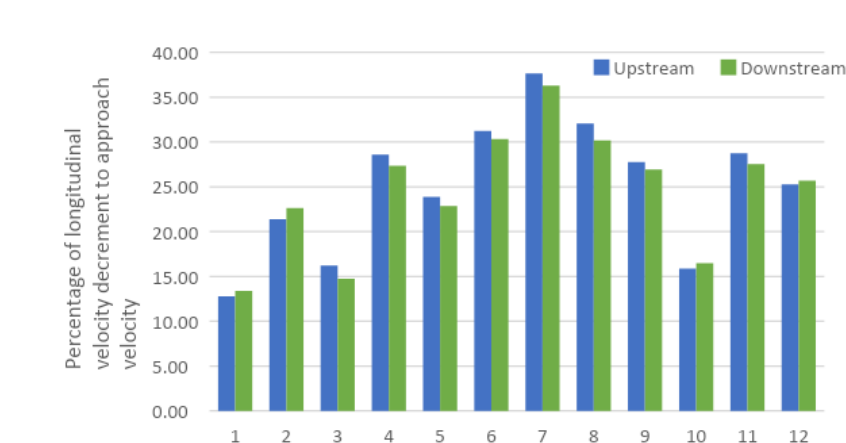
Figure 9. The ratio of the depth-averaged longitudinal velocity decrement to the approach velocity 0.02 m upstream and 0.02 m downstream of the spur